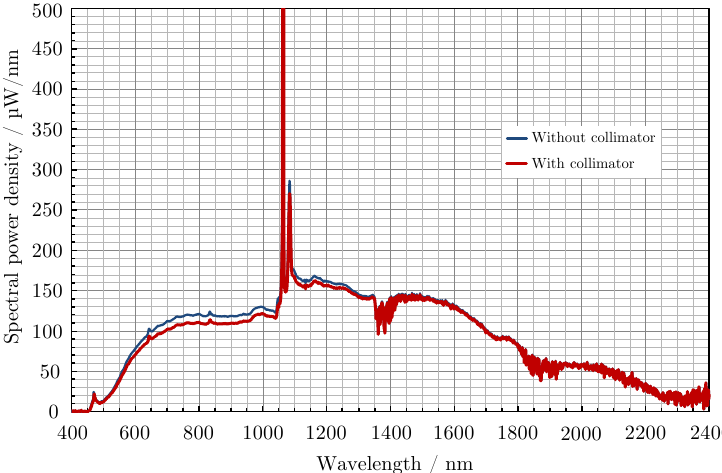
Figure 12. Declared power spectral density from manufacturer of the